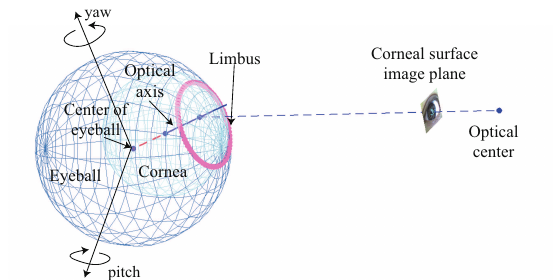
Figure 11 . A 3D eyeball model with an eyeball, cornea, and corneal limbus.